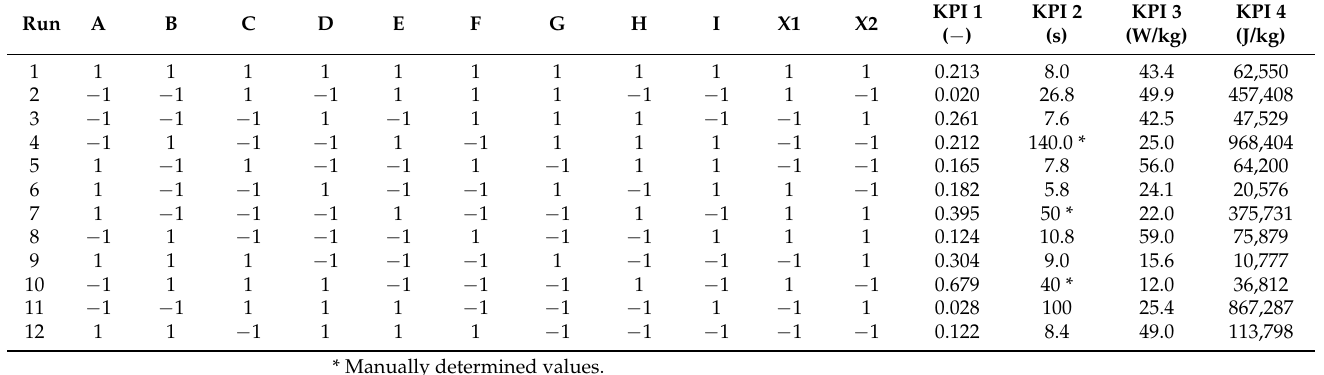
Table 5. Plackett–Burman (P–B) design with the resulting key performance indicators (KPIs); KPI 1 = average steady-state relative standard deviation (RSD); KPI 2 = time required to reach a steady-state RSD; KPI 3 = average energy per second per kilogram over full mixing period; KPI 4 = required energy to reach a steady state RSD.